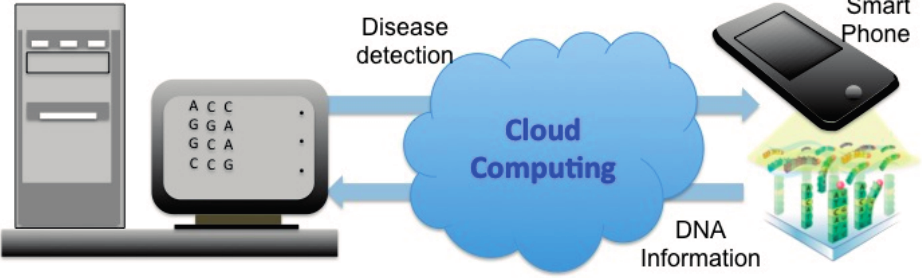
Figure 7. State of art technology of wireless handheld POC technology: Avatar DNA, for automatic identification using an optical machine-readable DNA icon on microarray. The telepathic DNA-DNA hybrids inscribed (on-chips) and identified by camera of smartphone with application